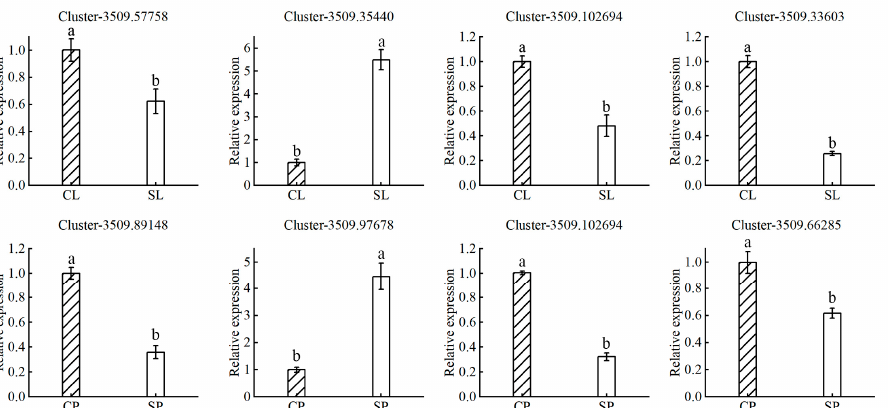
Figure 8. RT-PCR validation of differentially expressed genes. The expression of select genes identified as differentially expressed from the transcriptomic data were validated by RT-PCR in water lily leaves treated with control (CL) and 150 mM NaCl (SL) conditions and petioles treated with control (CP) and 150 mM NaCl (SP) conditions. Actin expression was used for normalization. Data are the means of three biological replicates (±SDs). Different letters indicate statistically significant differences ( p < 0.05).